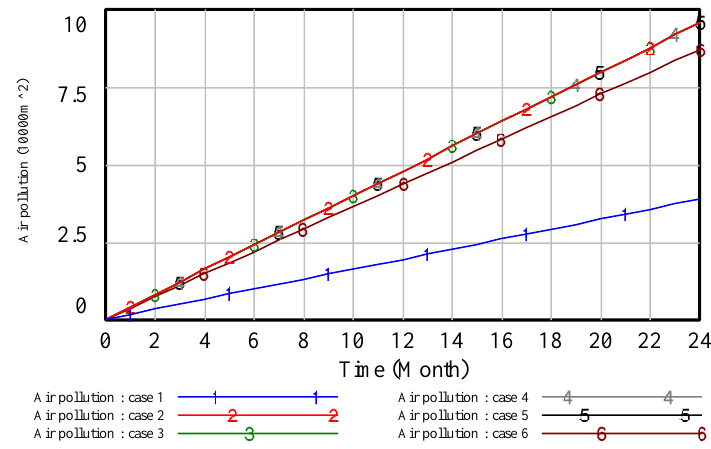
Int. J. Environ. Res. Public Health 2020 , 17 , x Figure 8. The simulation result of air pollution control. Figure 8. The simulation result of air pollution control.